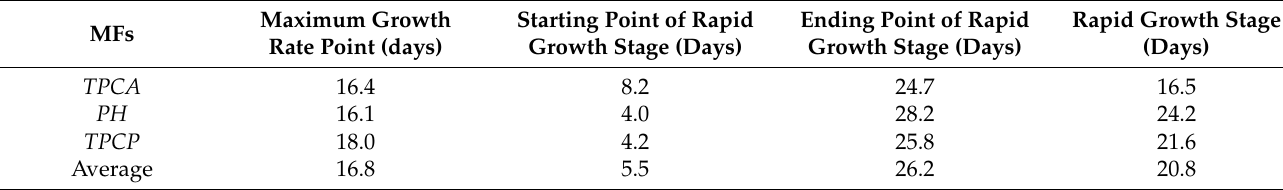
Table 5. Inflection points and rapid growth